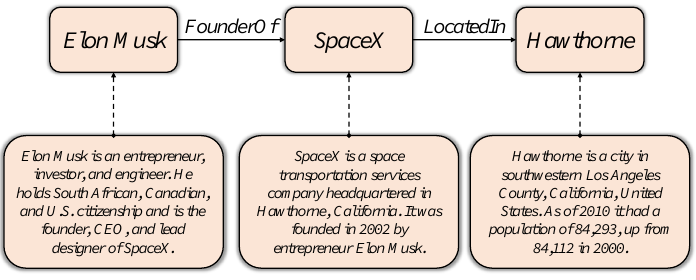
Figure 1. A simple instance of a knowledge